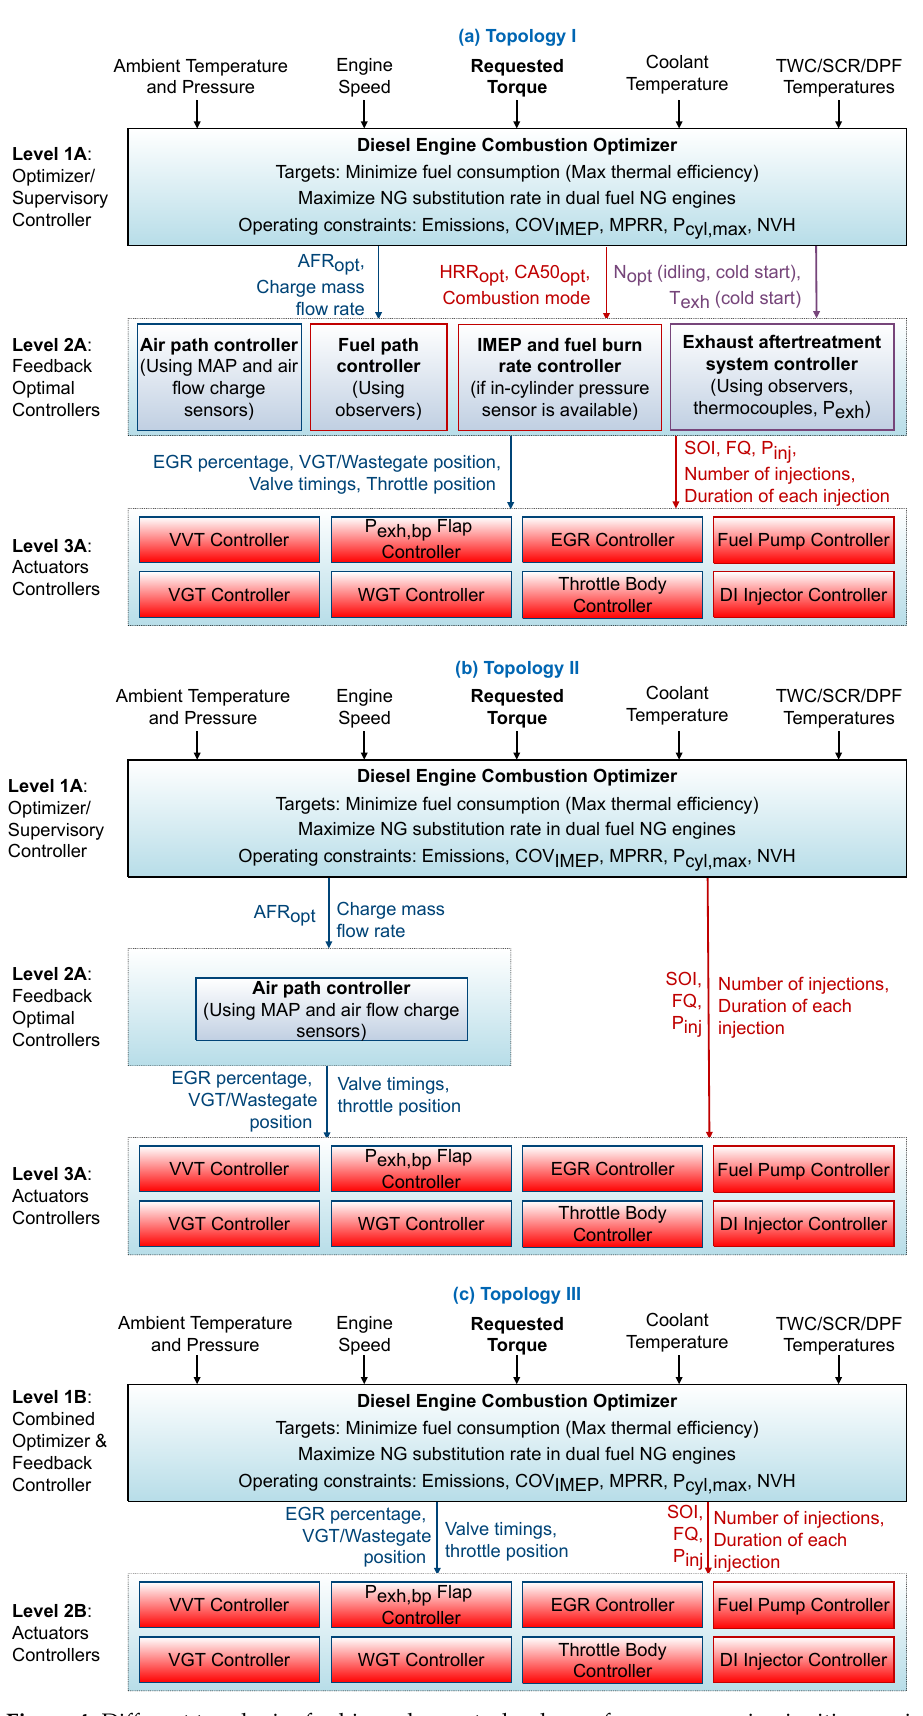
Figure 4. Different topologies for hierarchy control—shown for a compression ignition